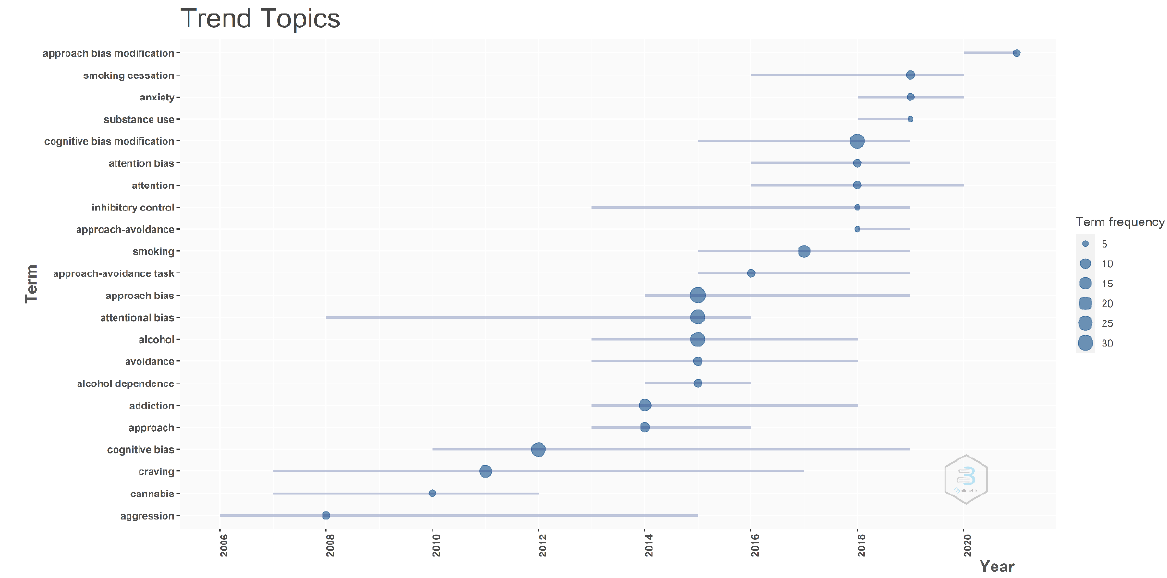
Figure 4. Trend of topics from 2006 to 2021.